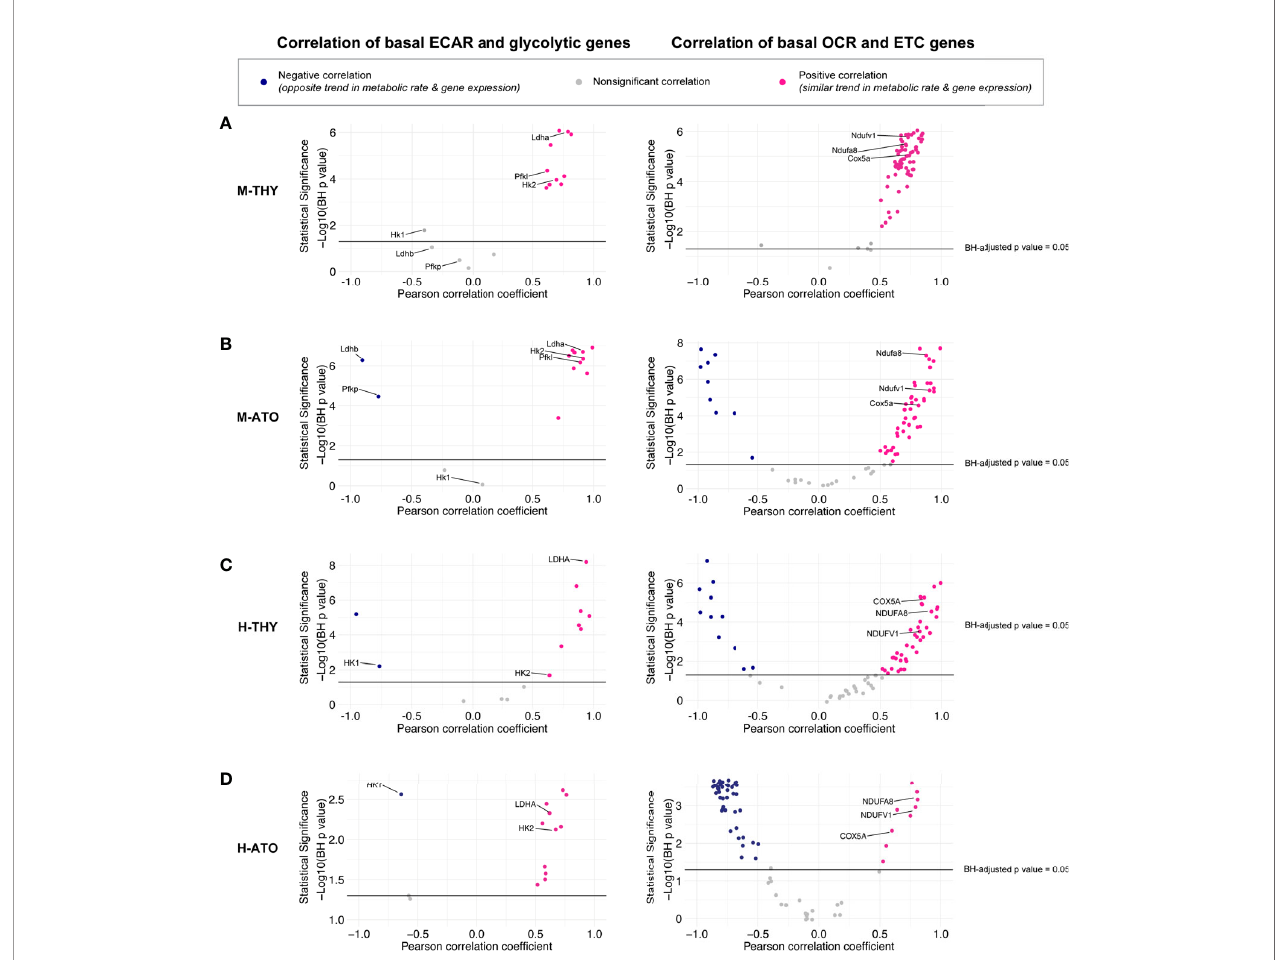
FIGURE 5 | (A – D) Scatter plots show correlation between (left) glycolytic enzyme gene expression and basal glycolysis (ECAR), or (right) correlation between electron transport chain gene expression and basal respiration (OCR) in (A) M-THY, (B) M-ATO, and (C) H-THY, and (D) H-ATO. The x axis represents the Pearson correlation coef fi cient R values calculated for individual genes within the speci fi ed metabolic pathway for all cell populations for which respective extracellular fl ux data was collected. The y axis represents the statistical signi fi cance of each R value using -log10 of Benjamini-Hochberg adjusted p-values. Solid black line indicates an adjusted p-value of 0.05; all R values above the line are statistically signi fi cant. Genes with R values >0.5 (pink) are positively correlated with metabolic fl ux data, while genes with R values <-0.5 (blue) are negatively correlated with metabolic fl ux data. Nonsigni fi cant or weak correlation R values >-.05 or <0.5 are indicated in grey. Certain genes of interest are indicated. (M-THY: n=6 fl ux analysis values for 5 populations, n=2 RNA-seq replicates; H-THY: n=3 fl ux analysis values for 5 populations, n=3 RNA-seq replicates; M-ATO: n=6 fl ux analysis values for 3 populations, n=2 RNA-seq replicates; H-ATO: n=6 fl ux analysis values for 3 populations, n=2 RNA-seq